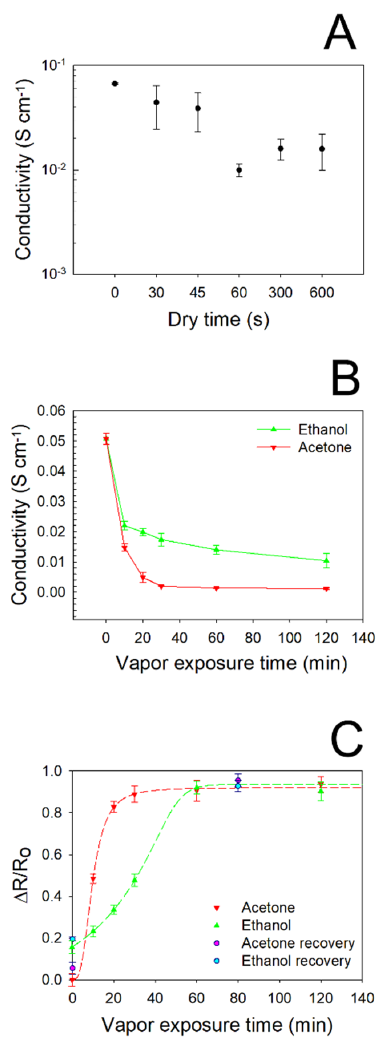
Figure 6. ( A ) Conductivity of PEGDA:PEDOT subjected to a 10 min acetone exposure after different drying times. ( B ) Conductivity of PEGDA:PEDOT for different exposure times to ethanol and acetone vapors. ( C ) Normalized resistance variation of the PEGDA:PEDOT samples versus acetone and ethanol exposure